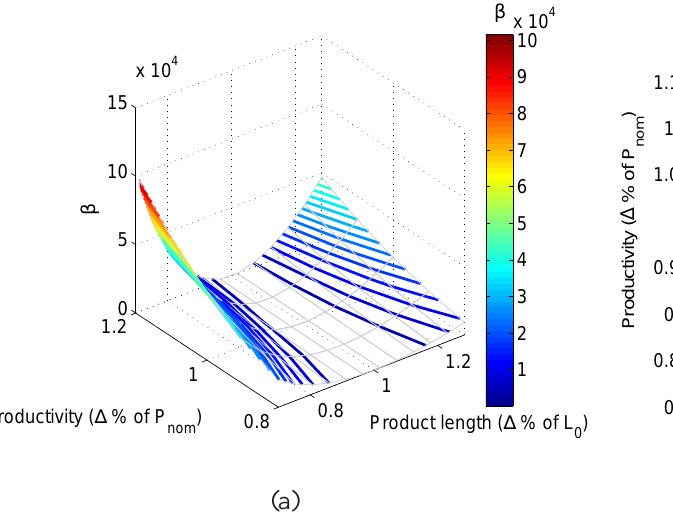
Figure 8. β as a function of product length and productivity.